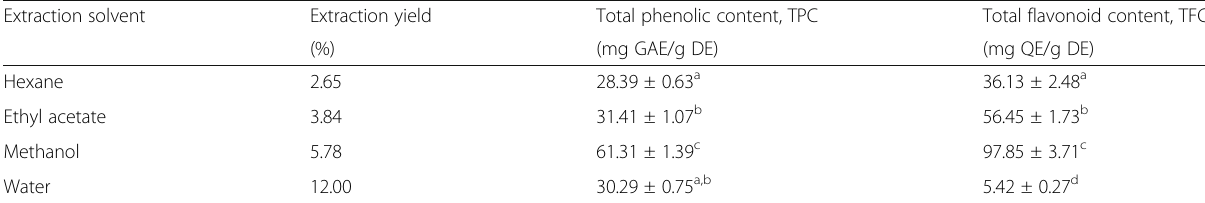
Table 1 Extraction yields and antioxidant components of MP Extraction solvent Extraction